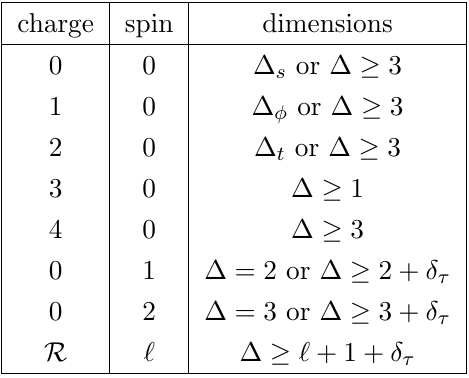
Table 3 . Typical assumptions about the spectrum of the O(2) model. In the last line, R ; ‘ represent any choices of representation R and spin ‘ not already represented in the table. A typical choice of twist gap is (cid:14) (cid:28) = 10 (cid:0) 6